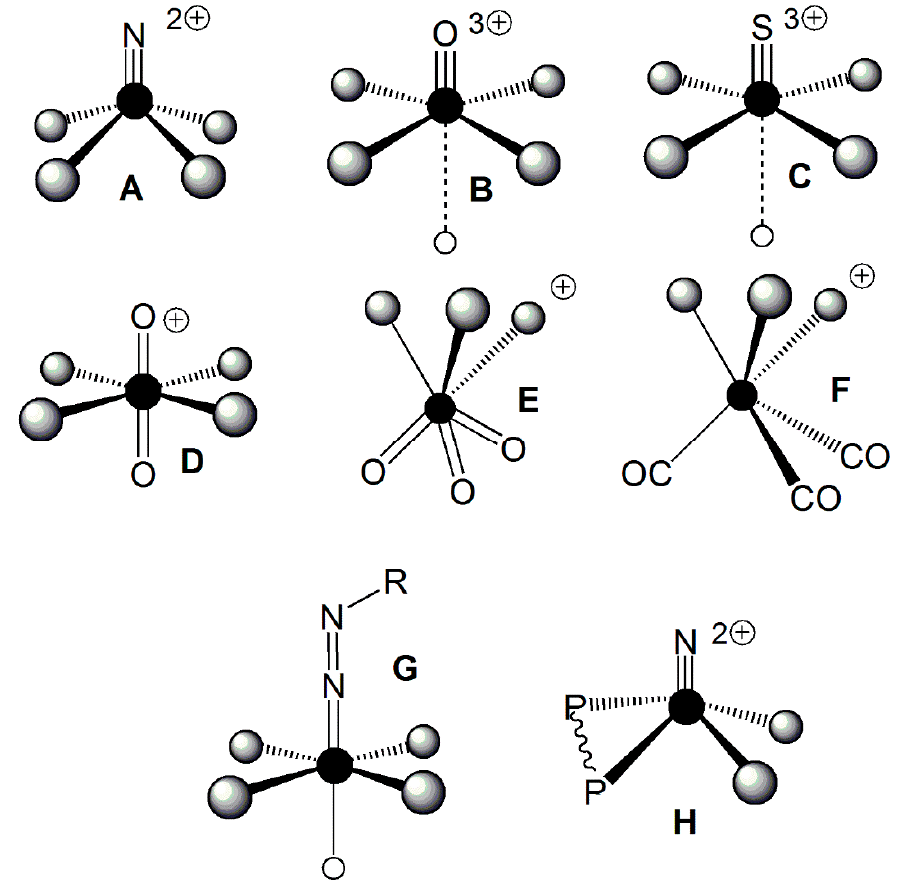
Figure 2. The most important technetium cores. Tc-nitrido ( A ); Tc-oxo ( B ); Tc-sulfido ( C ); Tc-dioxo ( D ); Tc-trioxo ( E ); Tc- tris -carbonyl ( F ); Tc-HYNIC ( G ); Tc-nitrido-diphosphane ( H ).